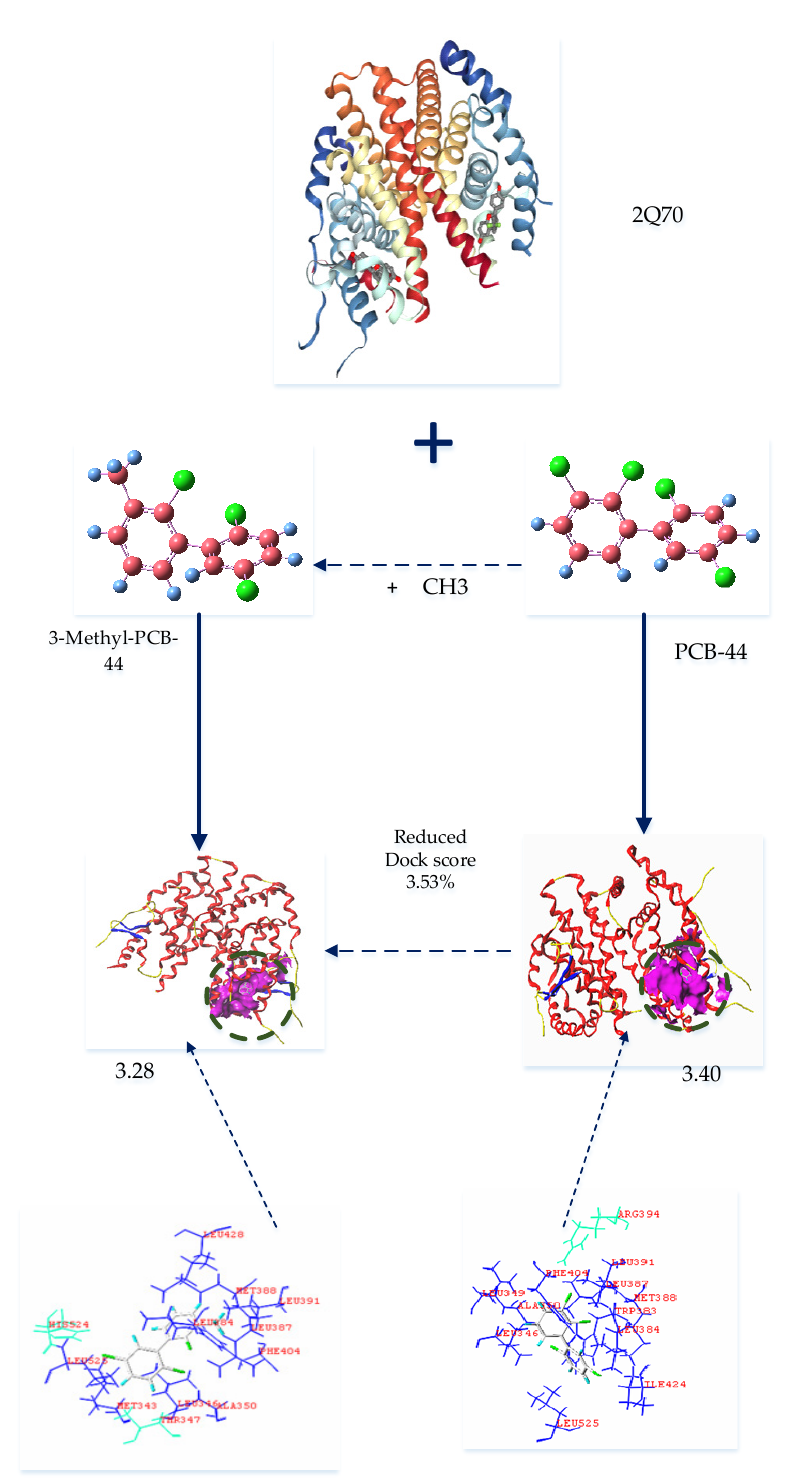
Figure 3. Binding conformation of 3-methyl-PCB-44 to 2Q70 receptor protein.